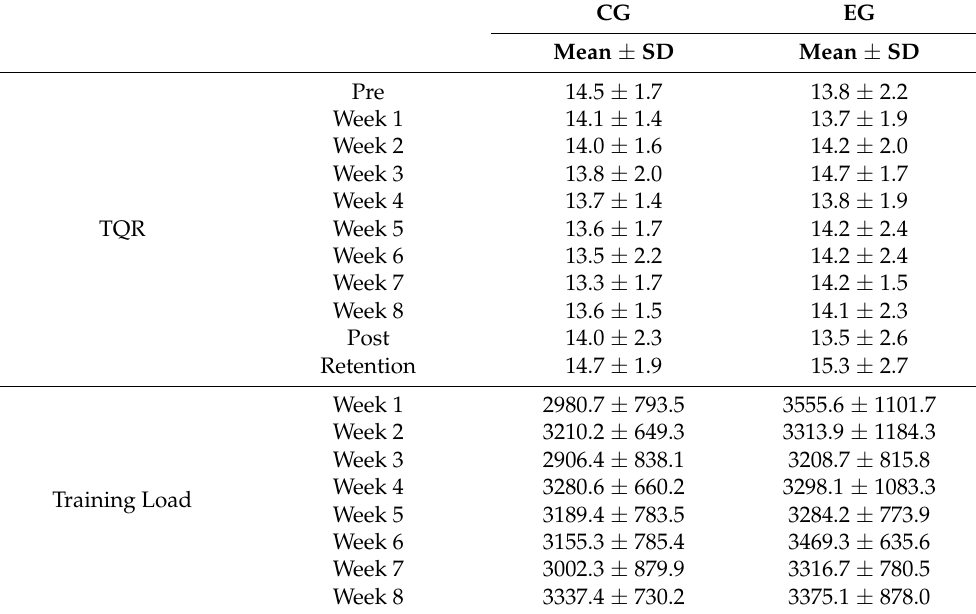
Table A3. TQR and Training Load